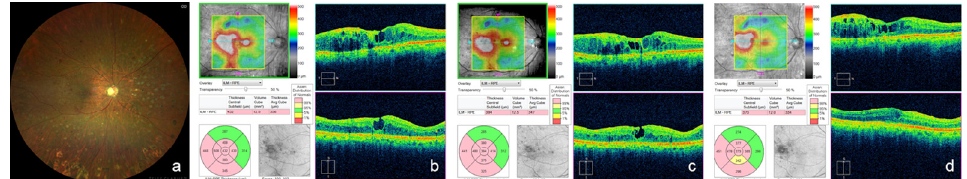
Figure 5. A treatment-naïve case (case 12) with a history of previous vitrectomy. ( a ) A color fundus photograph at baseline; ( b – d ) optical coherence tomography (OCT) images. Macular edema observed at baseline ( b ) remained unchanged during the intravitreal faricimab injection at 1 month ( c ). An OCT image at 5 months shows that the macular edema was refractory to the additional two intravitreal faricimab injections ( d ).